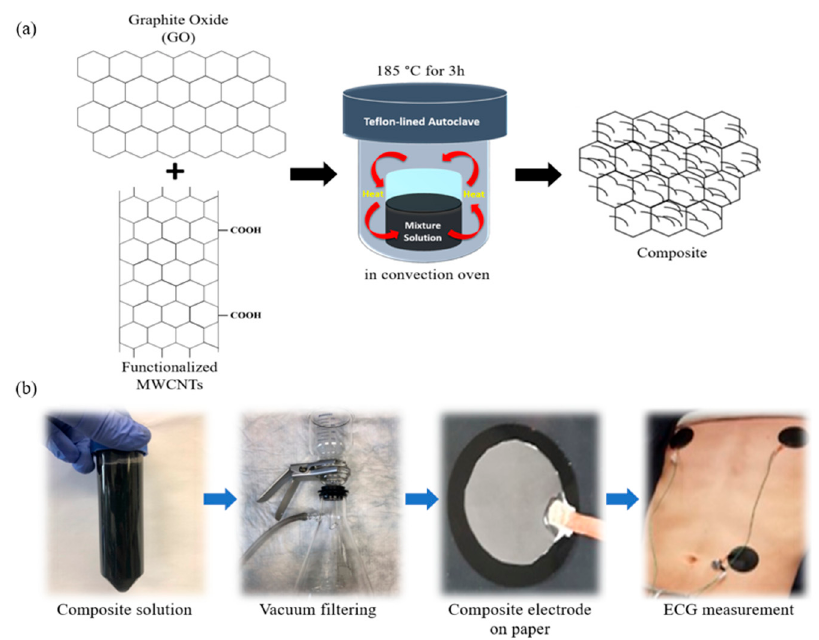
Figure 1. ( a ) Schematics of composite synthesis. ( b ) Illustration of electrode fabrication and measurement of ECG signal.